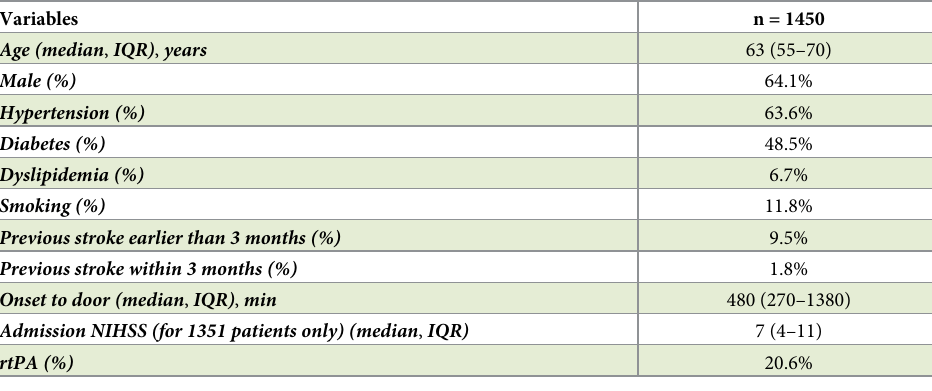
Fig 1. Flowchart of total cases of acute ischemic stroke from SITS of Ain Shams University 2 stroke centers. https://doi.org/10.1371/journal.pone.0238305.g001 Table 1. Descriptive results and clinical characteristics of the studied subjects.